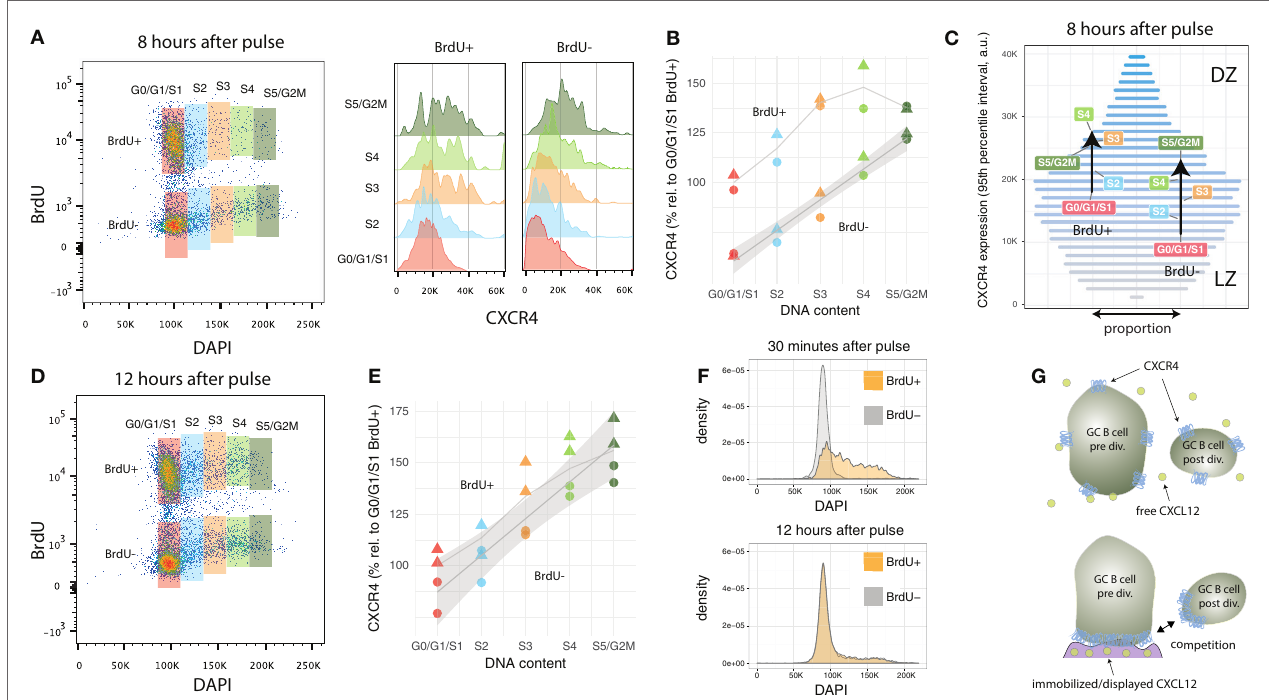
FiGUre 3 | CXCR4 kinetics 8 and 12 h after BrdU pulse. (a) Bi-variate scatter plot of DAPI (DNA content) versus BrdU 8 h after the pulse and corresponding CXCR4 expression profiles. (B) Average CXCR4 expression increases with cell cycle position in both recently divided BrdU + and relatively aged BrdU − cells. While BrdU + cells reach a plateau in mid-S at about 50% above their original value, BrdU − cells’ increase in average CXCR4 expression is unabated until G2M phase. Color and shape of the points indicate gate and mouse, respectively. (C) Changes in average CXCR4 expression compared to a representative CXCR4 expression profile. Bar widths correspond to the proportion of GC B cells with a specific CXCR4 expression level (color and y-axis position). DZ and LZ labels indicate that high and low CXCR4 expression is typically attributed to DZ and LZ phenotype, respectively. (d) Bi-variate scatter plot of DAPI (DNA content) versus BrdU 12 h after the pulse. (e) CXCR4 expression in the BrdU + and BrdU − subpopulation has converged indicating complete spatial mixing of individual GCs within approximately 12 h. Color and shape as in panel (B) . (F) Comparison of cell cycle distribution (DNA profile) of BrdU + and BrdU − cells 30 min and 12 h after pulse. (G) Proposed theoretical model in which immobilized or displayed CXCL12 leads to competition between cells prior and post division due to their difference in total numbers of CXCR4 receptors. Crucial to this model is the polarization of CXCR4 to the cell’s leading edge in the presence of CXCL12, which has been reported for T cells and various tumor cell lines, but remains to be shown for GC B